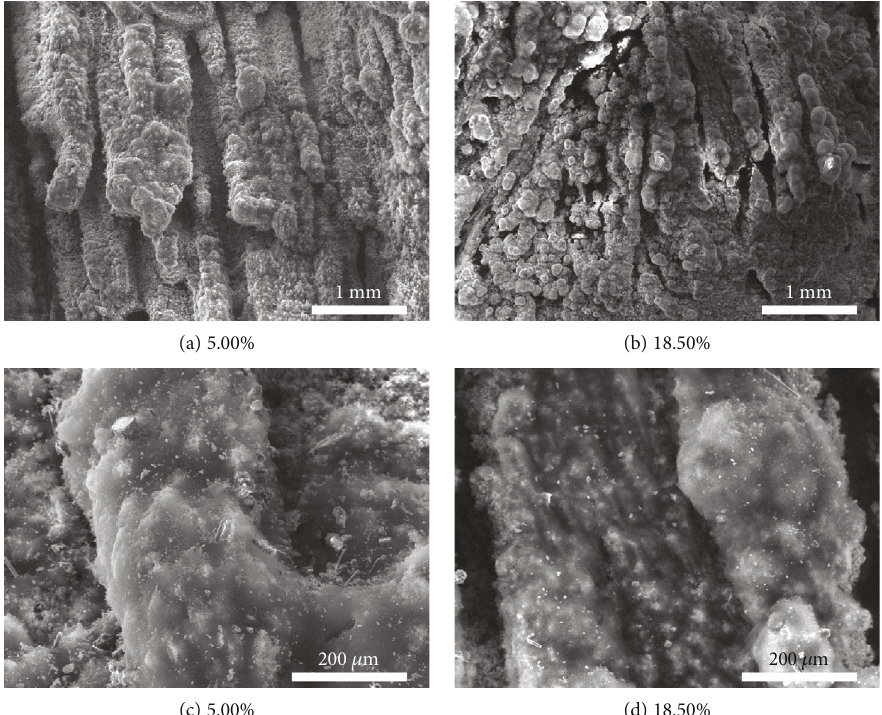
Figure 8: Ceramic layer morphology in the scour area under di ff erent oxygen-rich Table 6: Atomic percentage of the scour area under di ff erent oxygen-rich conditions. Element